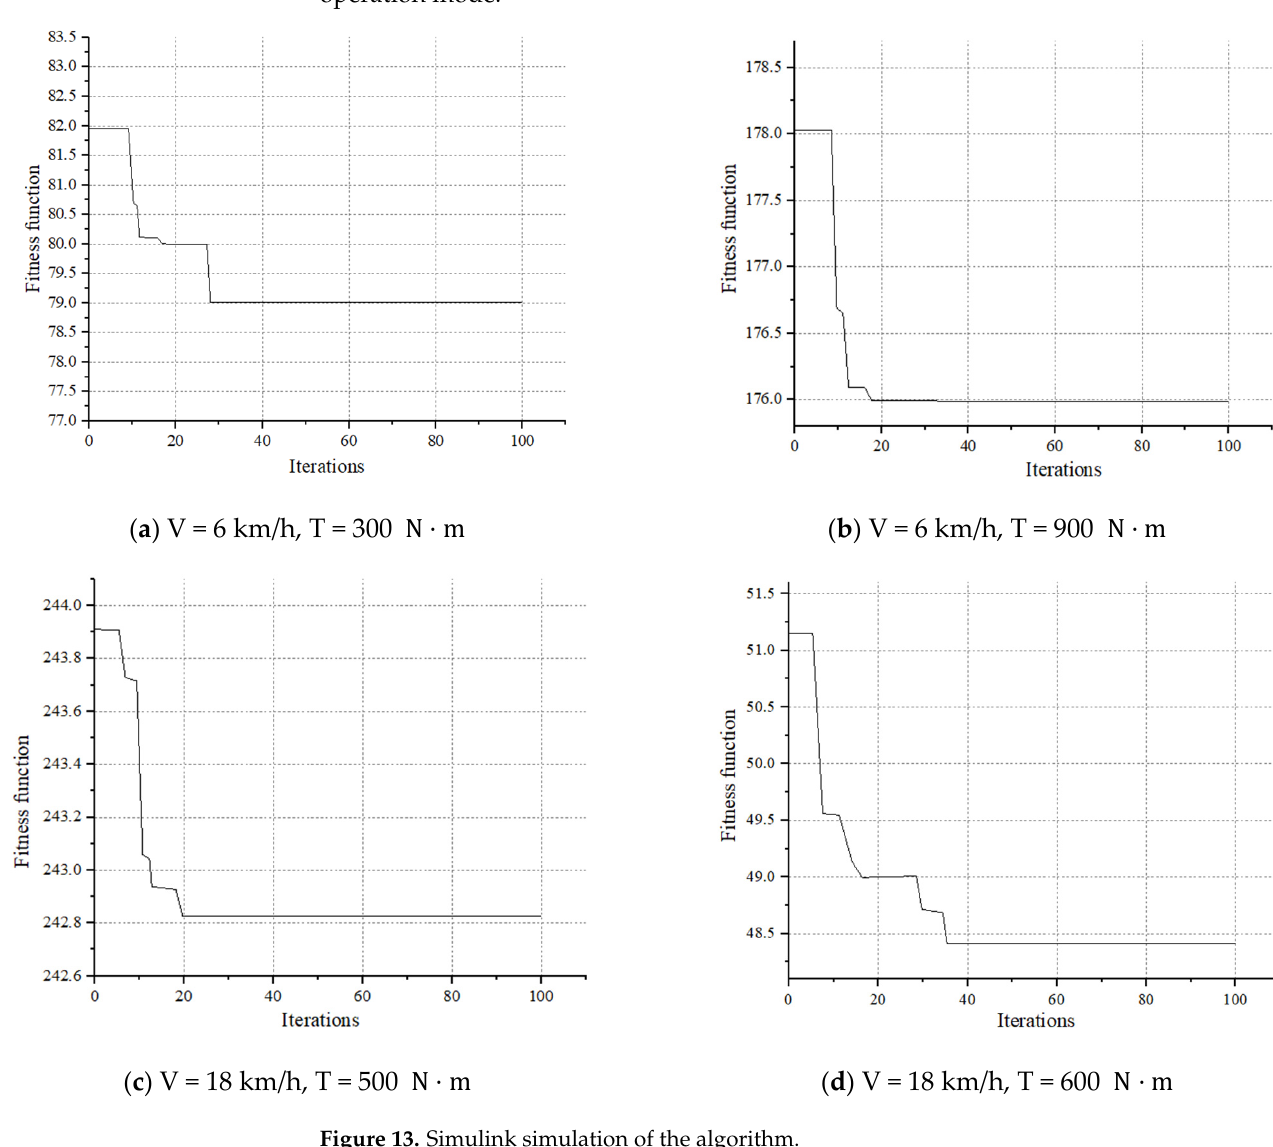
Figure 13. Simulink simulation of the algorithm. Table 6. PSO algorithm convergence speed